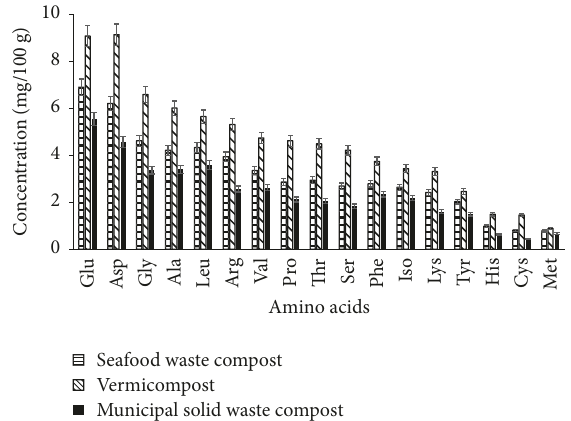
Figure 1: Amino acids composition in seafood waste compost, vermicompost, and municipal solid waste compost. Glu, glutamic acid; Asp, aspartic acid; Gly, glycine; Ala, alanine; Leu, leucine; Arg, arginine; Val, valine; Pro, proline; Thr, threonine; Ser, serine; Phe, phenylalanine; Iso, isoleucine; Lys, lysine; Tyr, tyrosine; His, histidine; Cys, cysteine; and Met,